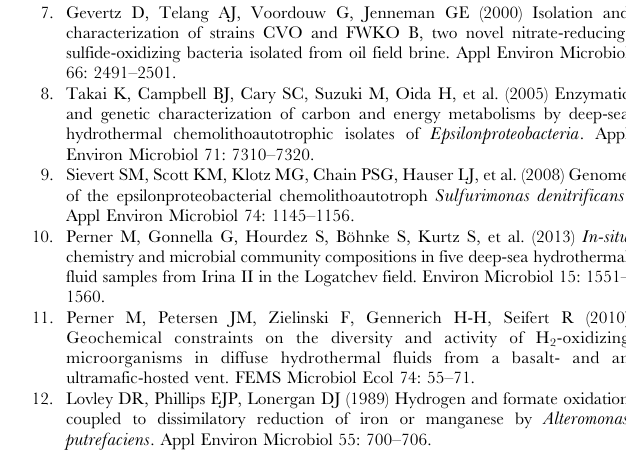
Table S1 Growth properties and significant differences in distinct culture experiments. S. denitrificans were incubated under different conditions as listed in Figure 1. For selected time points p-values were calculated using the student’s t-test. Table S2 Significant differences of growth, hydrogen consump- tion and hydrogen uptake activity for cultures grown without thiosulfate ( + H 2 2 S 2 O 32 2 ) and cultures grown with thiosulfate ( + H 2 + S 2 O 32 2 ). S. denitrificans were grown without thiosulfate ( + consumption and H 2 uptake activity are shown in Figure 1, Figure 2 and Figure 5, respectively. Statistics were performed using the student’s